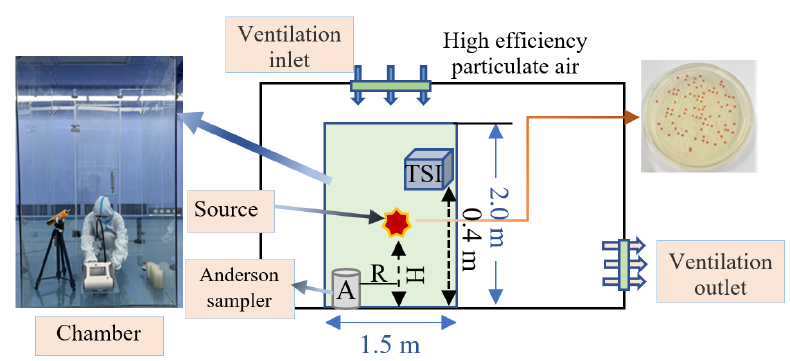
Figure 2. Experiment site and